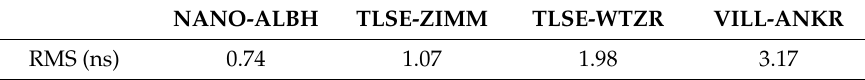
Table 3. Clock differ RMS of 7 days without ionosphere correction between stations.